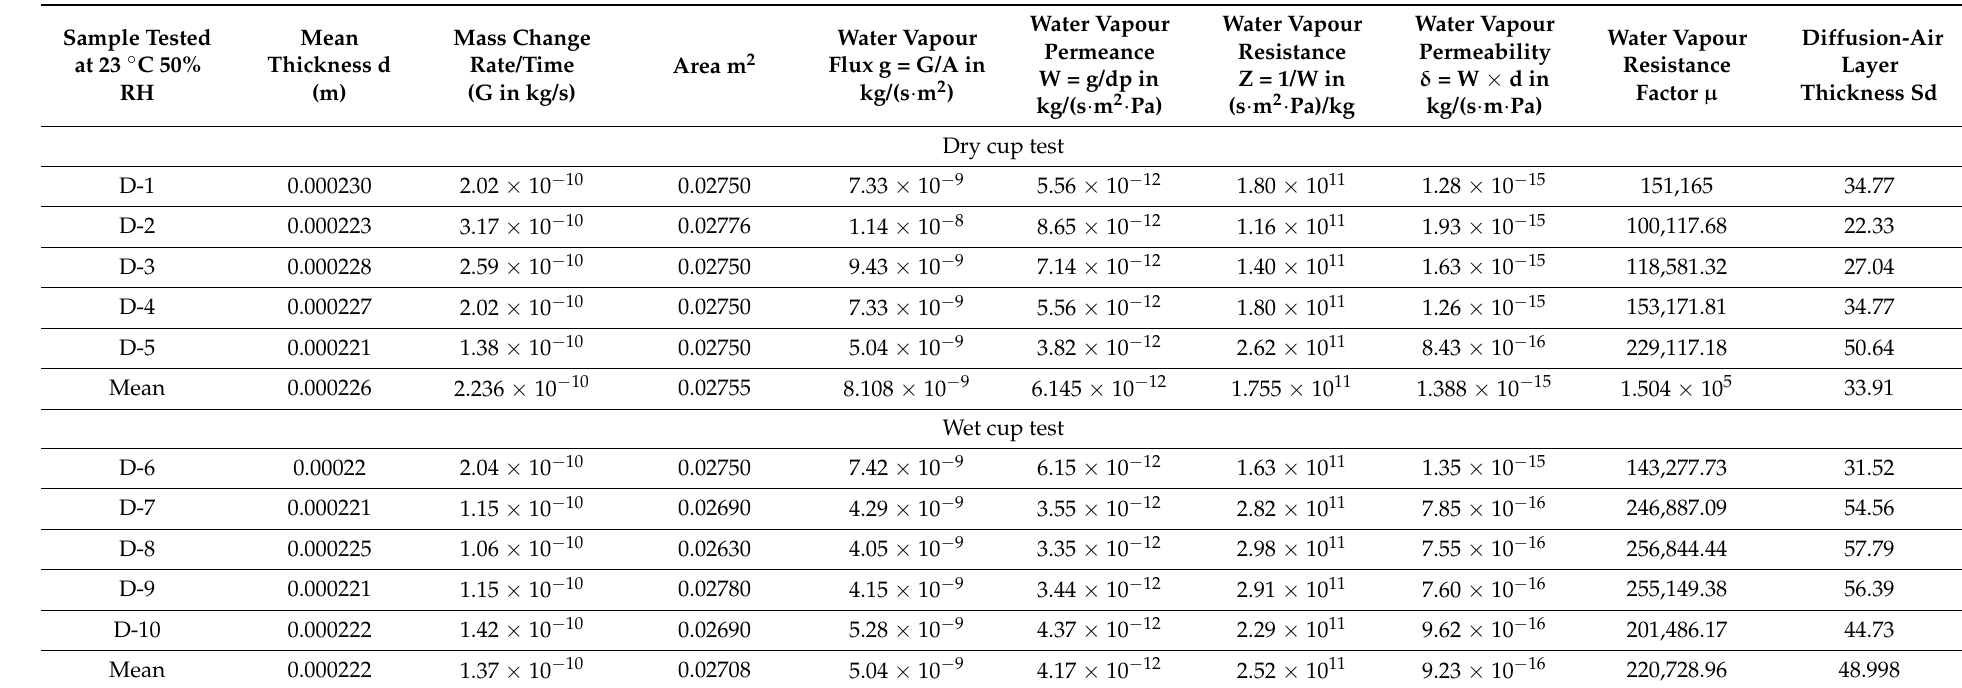
Table A7. Water vapour resistivity properties for sample D at 23 ◦ C 50%